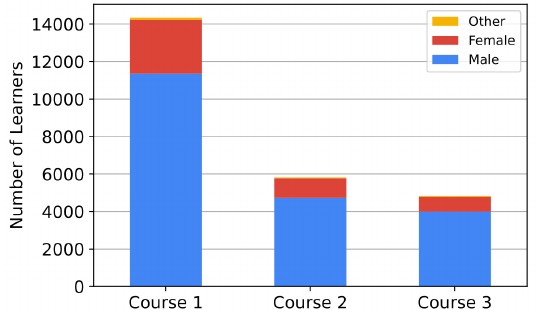
Figure 15. Gender demographics based on voluntarily provided information. Collectively, we are working on engaging a more diverse population of learners with the aid of working groups that are part of the tinyML